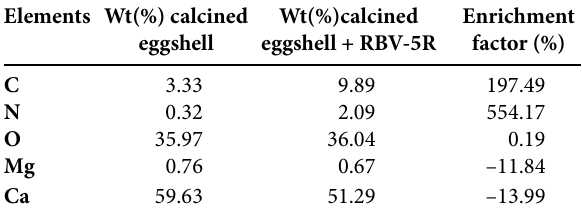
Table 7. Results of EDX analyses